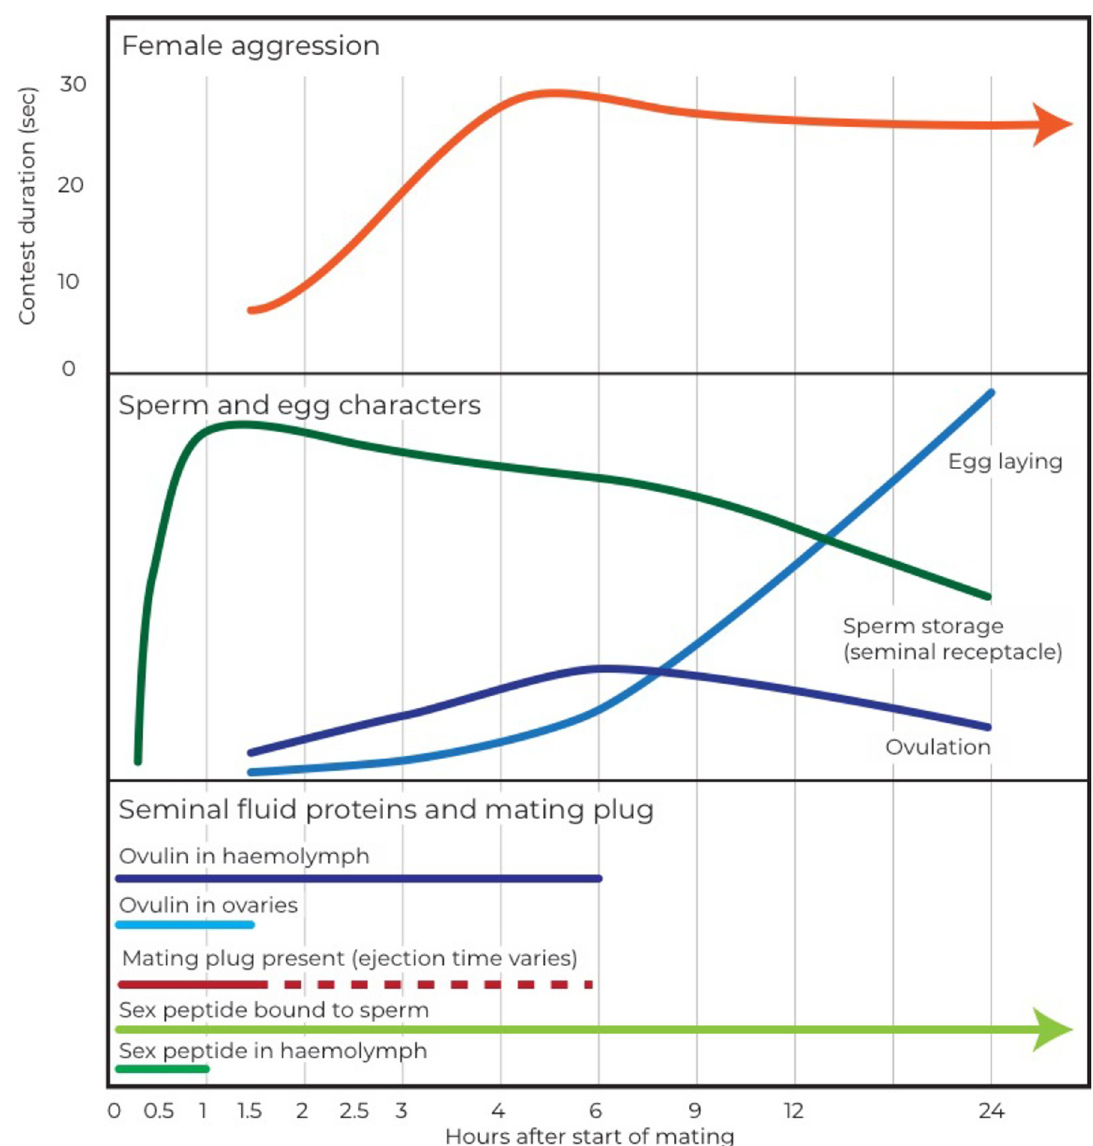
Fig 4. Schematic of timing of various processes in mated females for the first 24 hours after mating. A. The top portion of the figure represents aggression in mated females over the first 24 hours after mating as contest duration in seconds. This matches Fig 1 in this paper. B. The middle part of the figure demonstrates the patterns of sperm storage (in the seminal receptacle only), egg laying (oviposition), and ovulation in mated females. These lines represent general patterns and are not to scale with each other, but merely to give an indication of when and how these processes change over time. Sources: sperm storage [27], ovulation [26], egg laying [26]. C. The bottom portion of the figure demonstrates the timing of the presence of various seminal fluid proteins in different parts of the female–e.g. the top line represents when ovulin has been detected in the female hemolymph after mating. Sources: ovulin in hemolymph [53,54],ovulin in ovaries [26], mating plug and sperm ejection [23,55],sex peptide bound to sperm [56], sex peptide in hemolymph